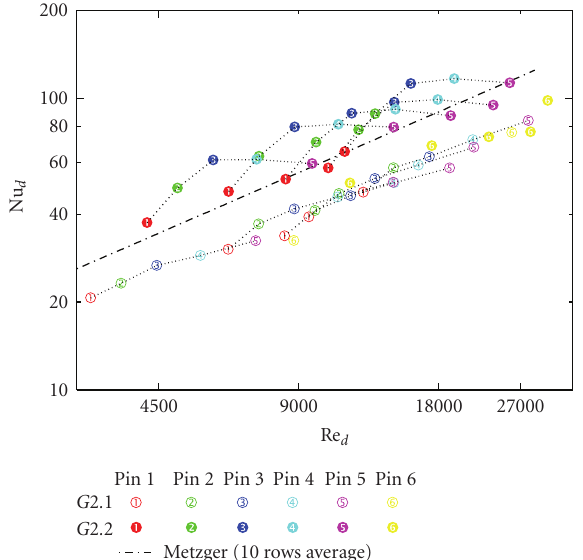
Figure 7: Row by row heat transfer data.